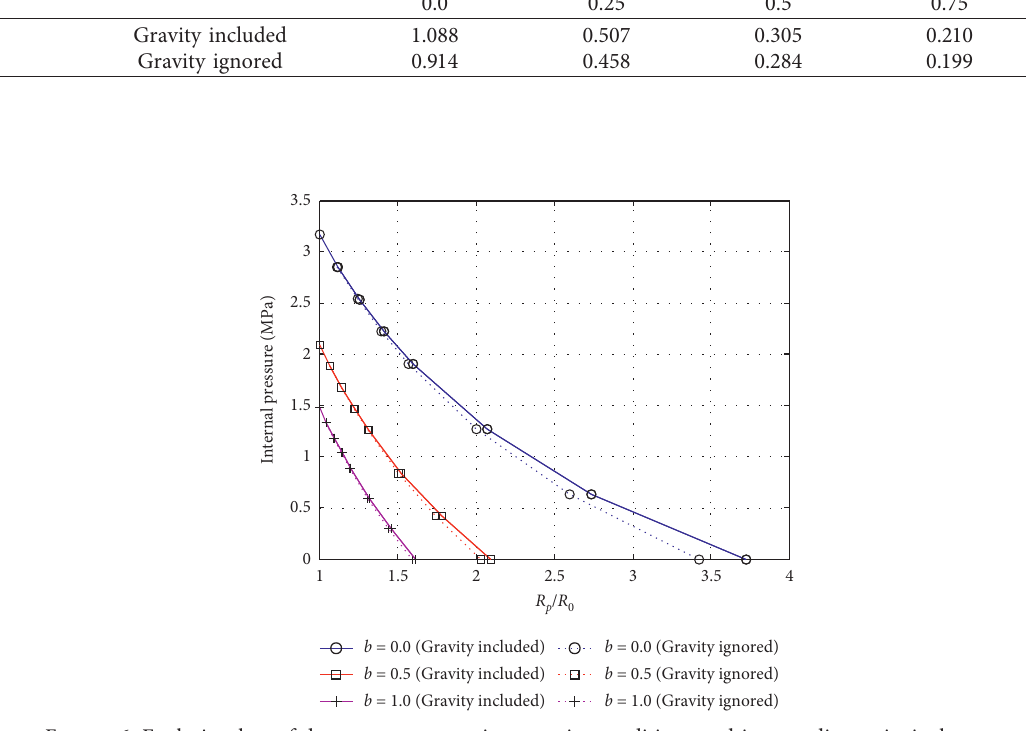
Figure 6: Evolution law of damage zone at various gravity conditions and intermediate principal